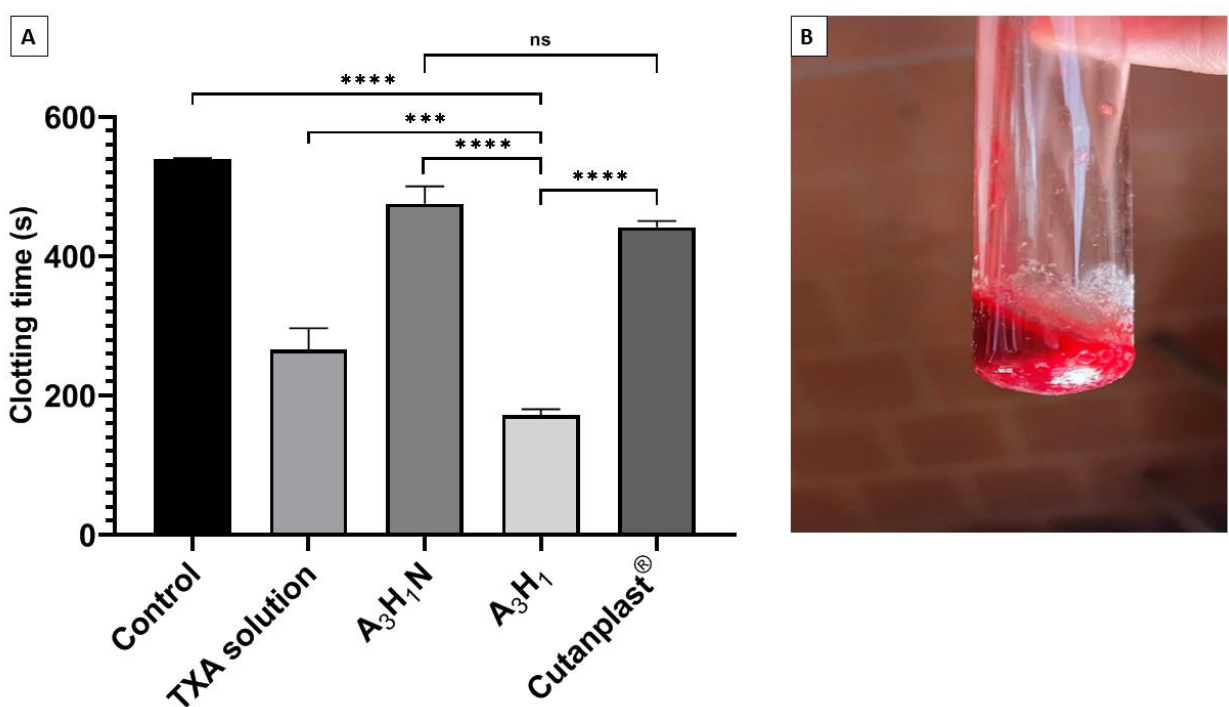
Figure 4. ( A ) Blood clotting time test for the optimum aerogel with tranexamic acid (A 3 H 1 ) and without tranexamic acid (A 3 H 1 N), tranexamic acid solution, Cutanplast ® , and negative control (without any material added) and ( B ) clotting test for A 3 H 1 . ns = p > 0.05, *** = p ≤ 0.001, and **** = p ≤ 0.0001.